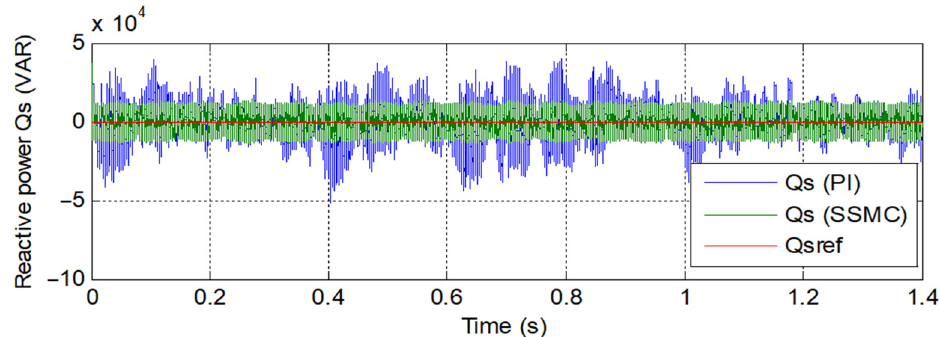
Figure 7. Reactive power.